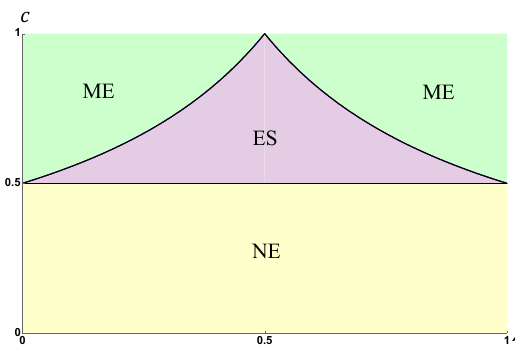
Figure 4 . Entanglement phase diagram for the infinite temperature equilibrated pure